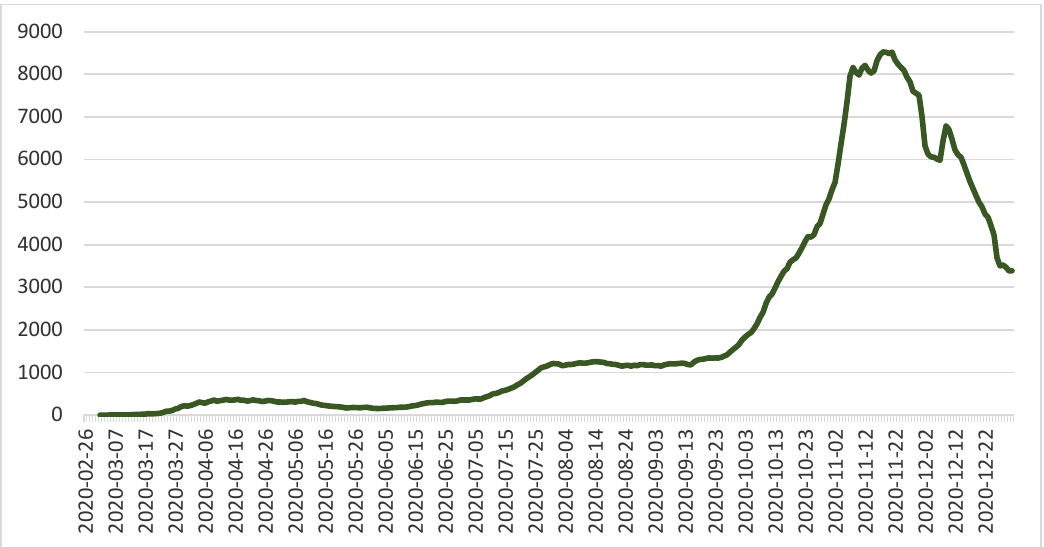
Figure 2. The evolution in the number of individuals tested positive (new cases smoothed) with